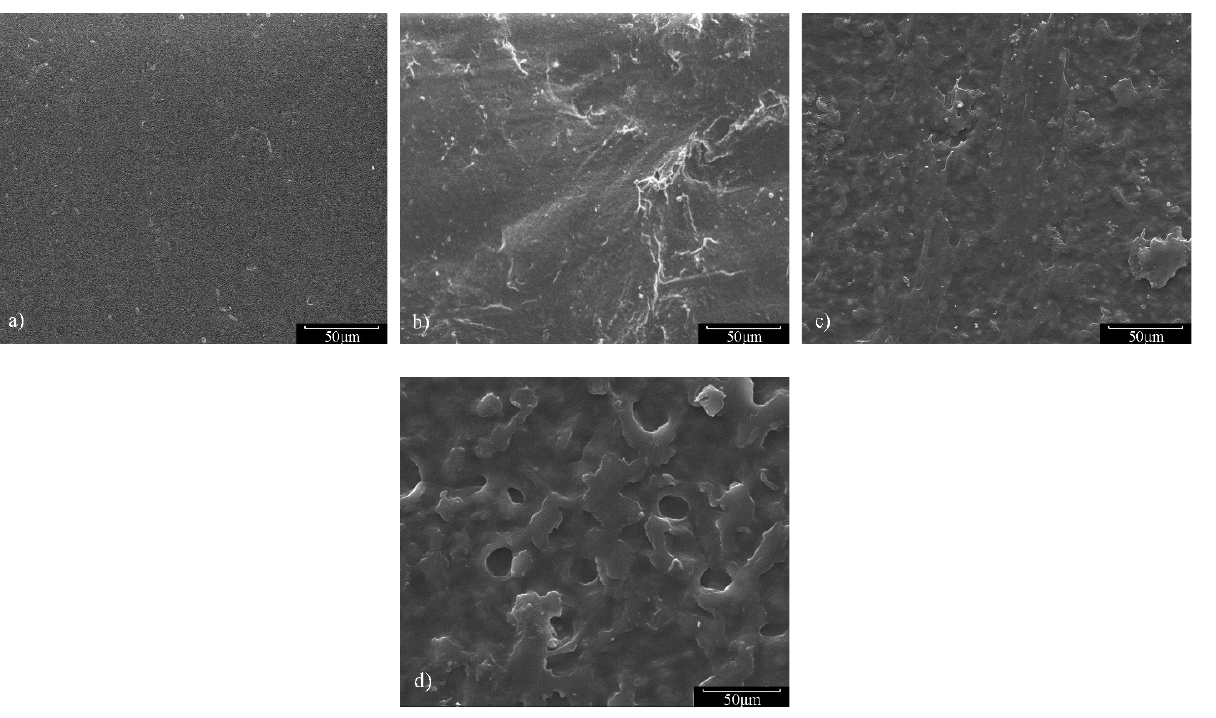
Figure 9. SEM images of PEU ‐ 2.0 film following ( a ) 0, ( b ) 4, ( c ) 8 and ( d ) 12 months’ degradation.